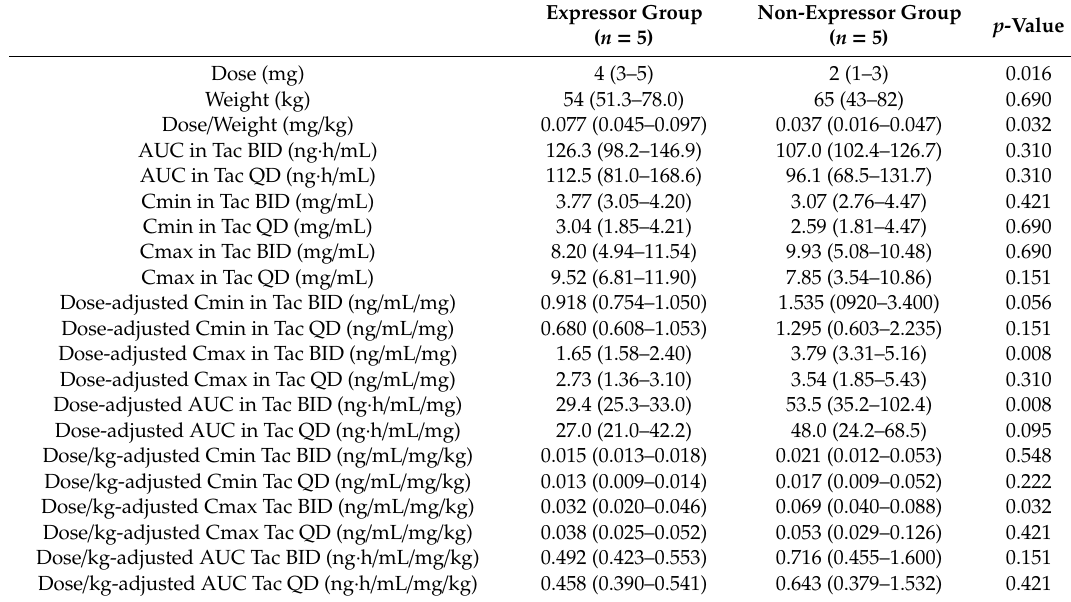
Table 3. Pharmacokinetic parameters of tacrolimus stratified according to CYP3A5